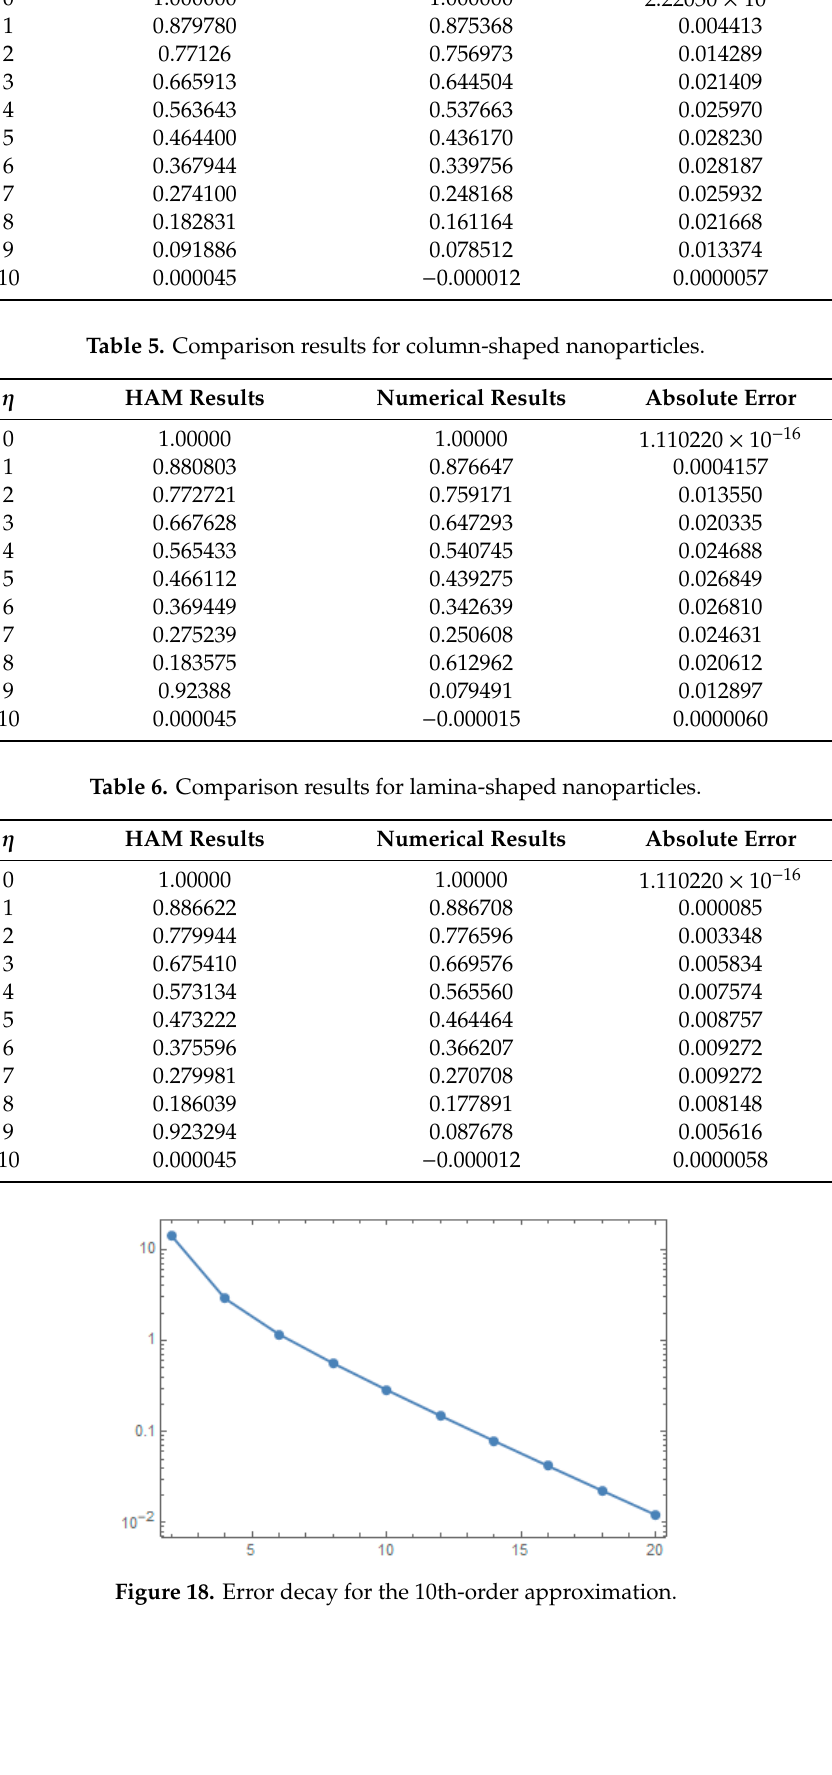
0.000048 Table 4. Comparison results for platelet-shaped nanoparticles.